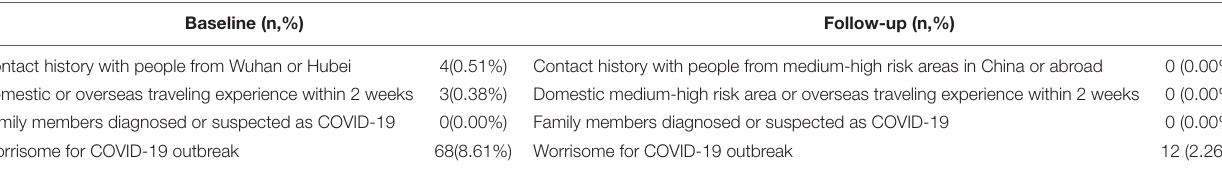
TABLE 2 | Exposure history and worrisome to COVID-19 outbreak and